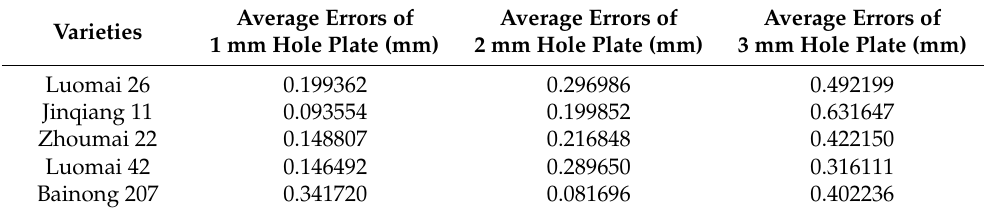
Table 1. Average errors of different hole plates for detecting long and short